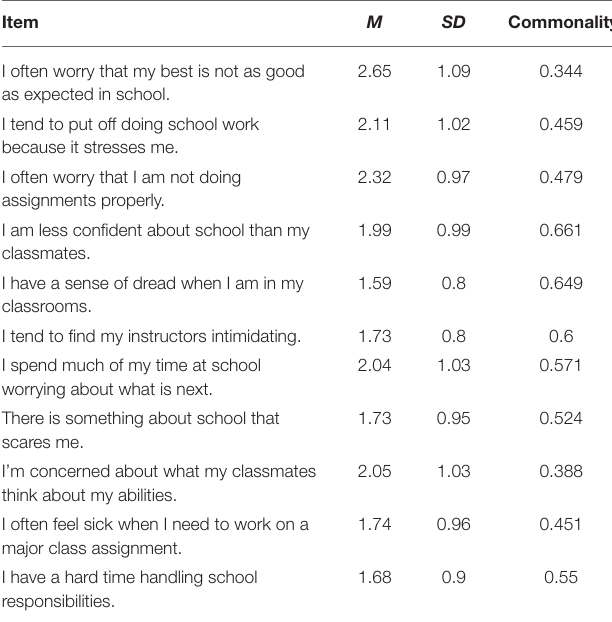
TABLE 1 | Item analysis of the academic anxiety scale ( N =